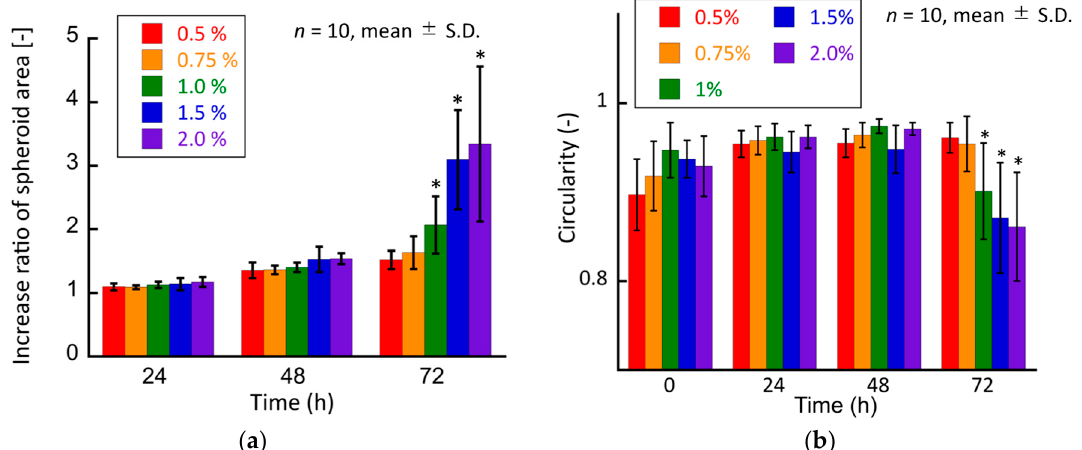
Figure 8. Quantitative analyses of the tumor spheroids cultured in agarose gels. ( a ) Increase ratio of the spheroid area and ( b ) circularity of the spheroid. * indicates a significant difference compared to the 0.5% agarose gel groups ( p < 0.05).